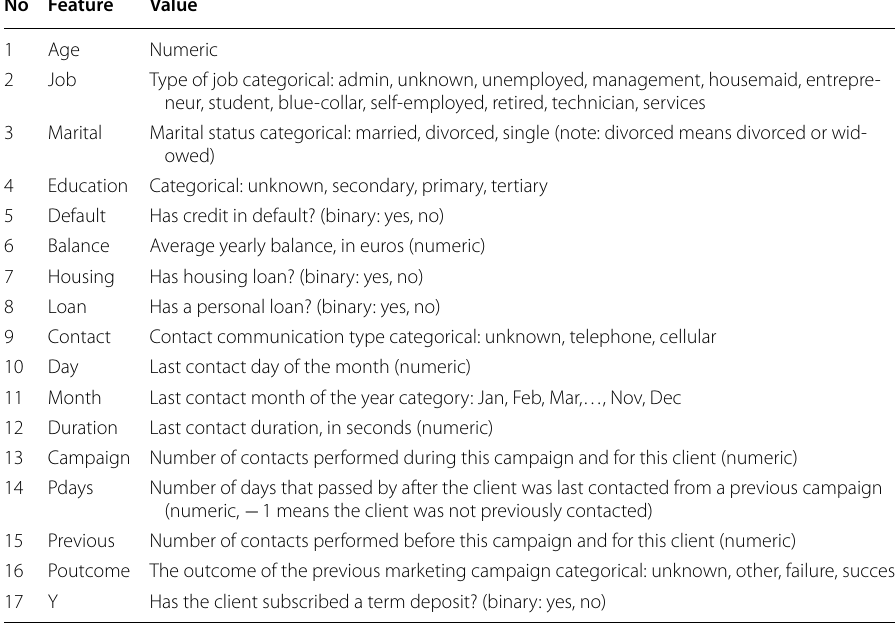
Table 4 Feature description bank marketing dataset